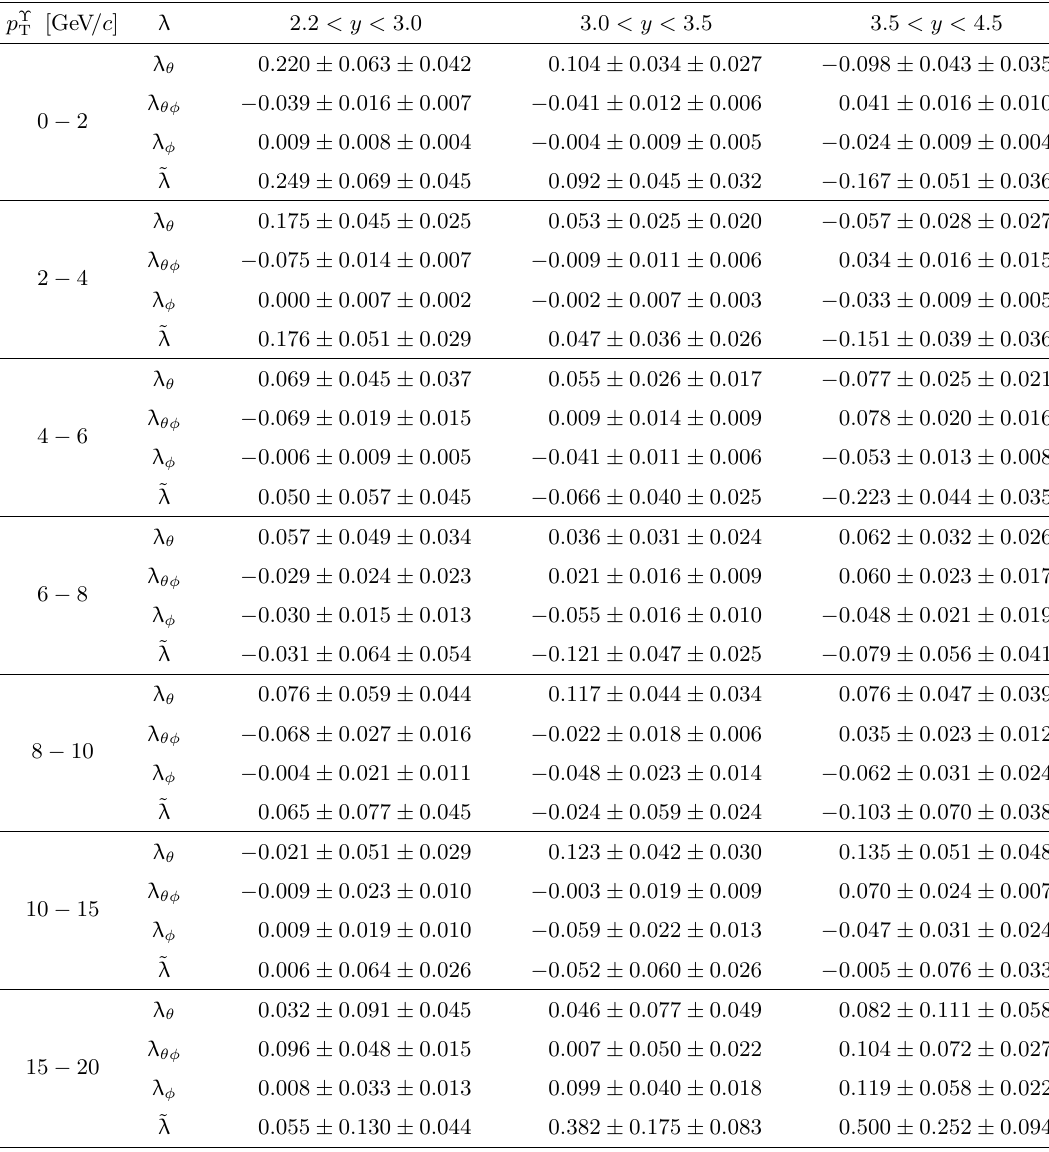
Table 2 . Values of (cid:21) (cid:18) , (cid:21) (cid:18)(cid:30) , (cid:21) (cid:30) and ~ (cid:21) measured in the HX frame for the (cid:7)(1S) produced at p s = 7 TeV. The (cid:12)rst uncertainty is statistical and the second systematic. A Polarization results for the (cid:7)(1S) state Values of the polarization parameters (cid:21)(cid:21)(cid:21) and ~ (cid:21) for the (cid:7)(1S) meson are presented in tables 2 and 3 for the HX frame, in tables 4 and 5 for the CS frame and in tables 6 and 7 for p the GJ frame for s = 7 and 8 TeV, respectively. The polarization parameters (cid:21)(cid:21)(cid:21) measured in the wide rapidity bin 2 : 2 < y (cid:7) < 4 : 5 are presented in tables 8 and 9, while the parameters ~ (cid:21) are listed in table 10.